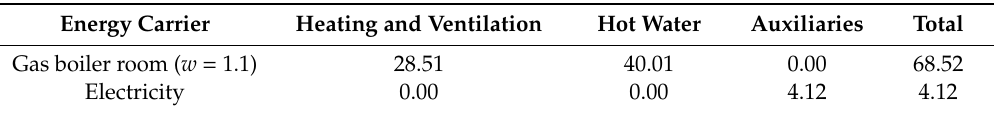
Table 9. The annual final energy demand (kWh / (m 2 · year)) for the multi-family building at Akacjowa Street in Goleniow (gas boiler